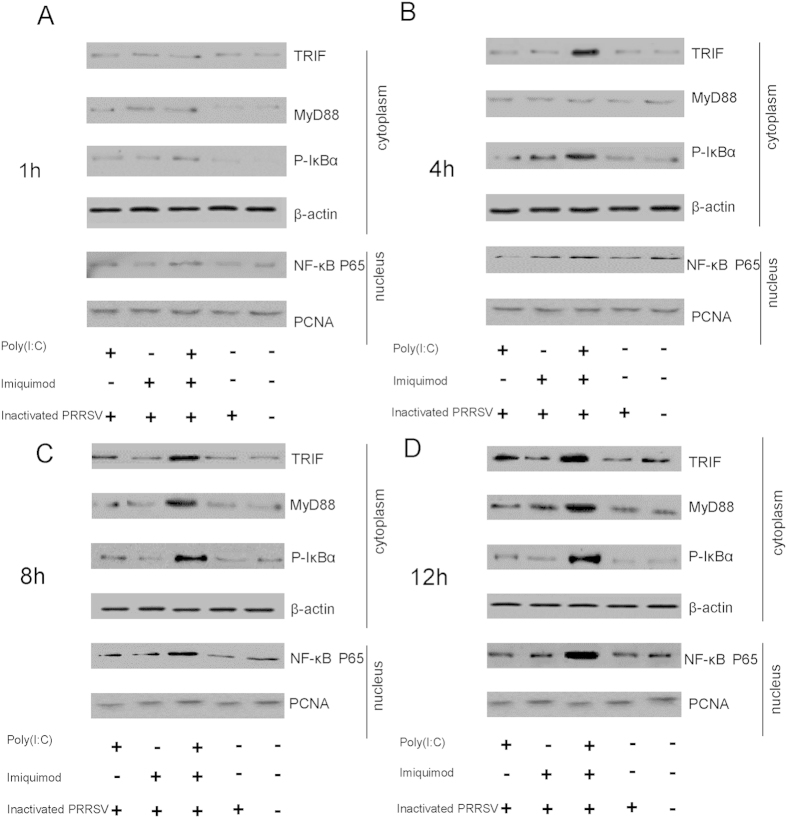
The protein levels of TRIF, MyD88, phospho-IκBα and NF-κB P65 in MoDCs stimulated with TLR ligands and inactivated PRRSV antigen for different times.MoDCs were incubated with poly (I: C) and/or imiquimod along with inactivated PRRSV antigen for 1 h, 4 h, 8 h and 12 h, the inactivated PRRSV antigen and RPMI-1640 were used as control. The protein levels of TRIF, MyD88, phospho-IκBα in cytoplasm and the protein levels of NF-κB P65 in nucleus were detected by western blotting. β-actin and PCNA were used as loading control in cytoplasm and nucleus, respectively. The data presented here are results from one experiment of three western blotting experiments.